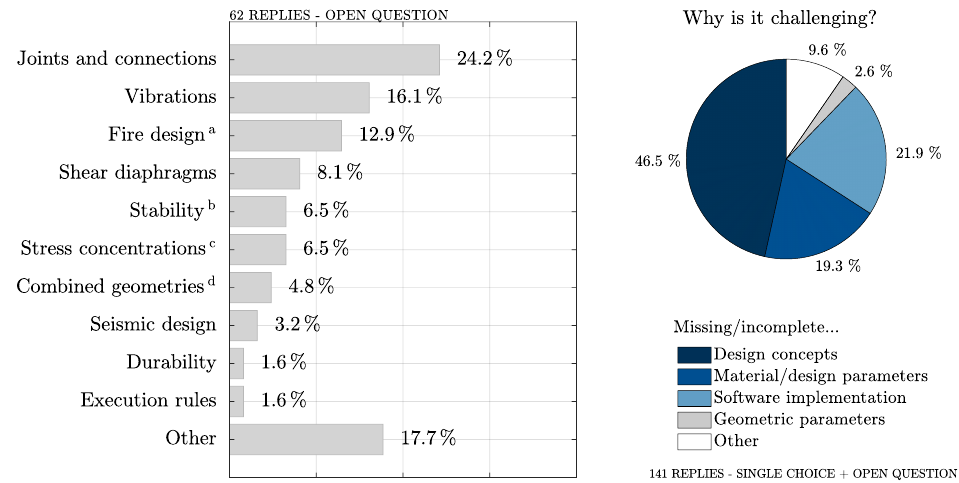
Figure 14. Other challenging situations. Given reasons: a resistance and compartmentalization;